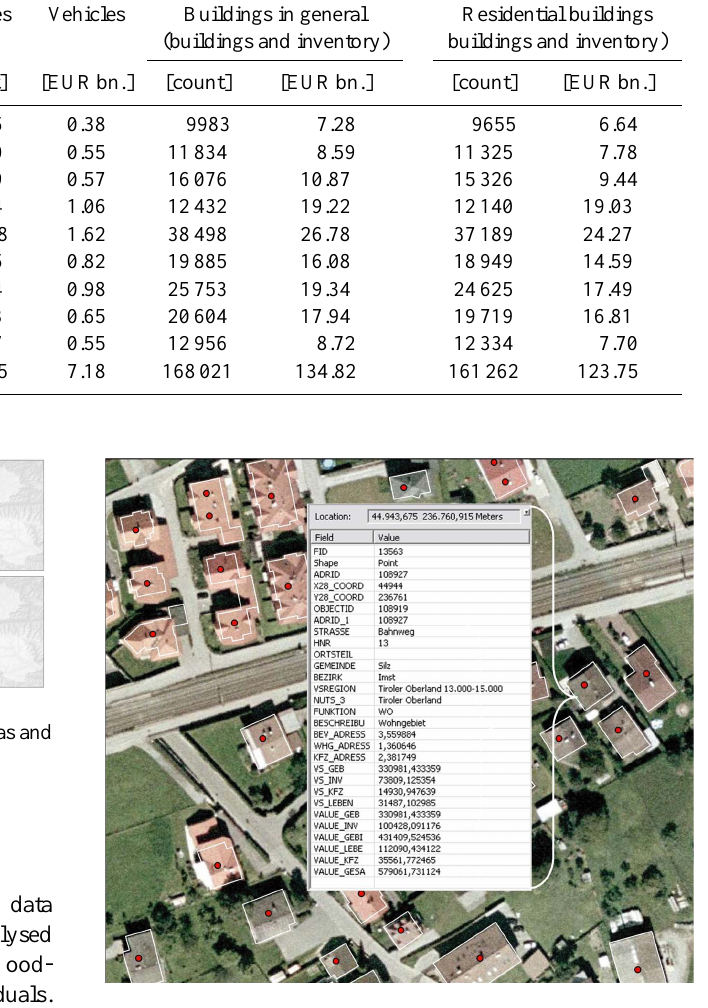
Fig. 7. Exemplary visualisation of the stock of elements and values for a single address point resulting from the property-by-property geodatabase. The table shows a summary of the most relevant infor- mation for the displayed object (e.g. VALUE GEBI: building and inventory value of the presented object). More detailed information is saved in the